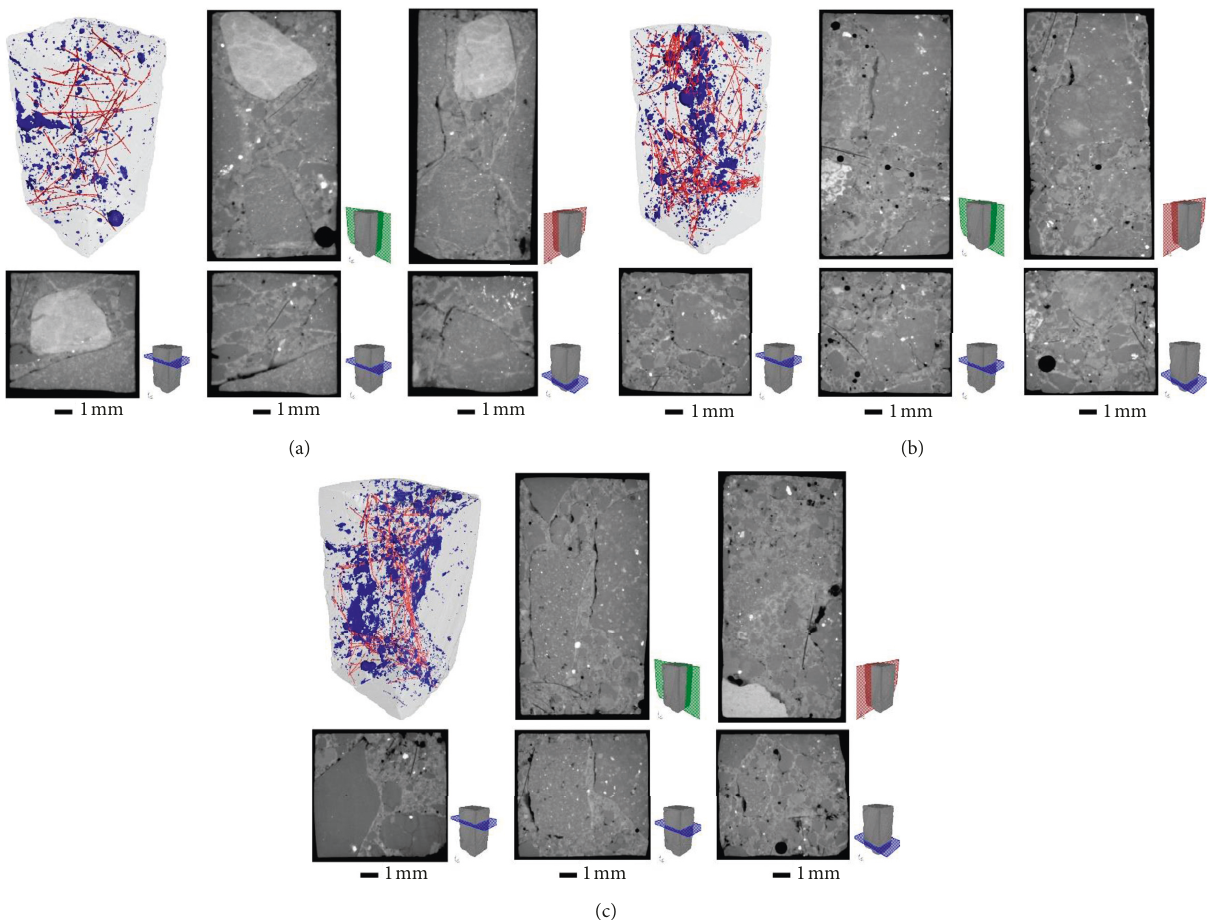
Figure 5: X-ray CT images of specimens: (a) fiber volume fraction is 0.10%; (b) fiber volume fraction is 0.20%; (c) fiber volume fraction is